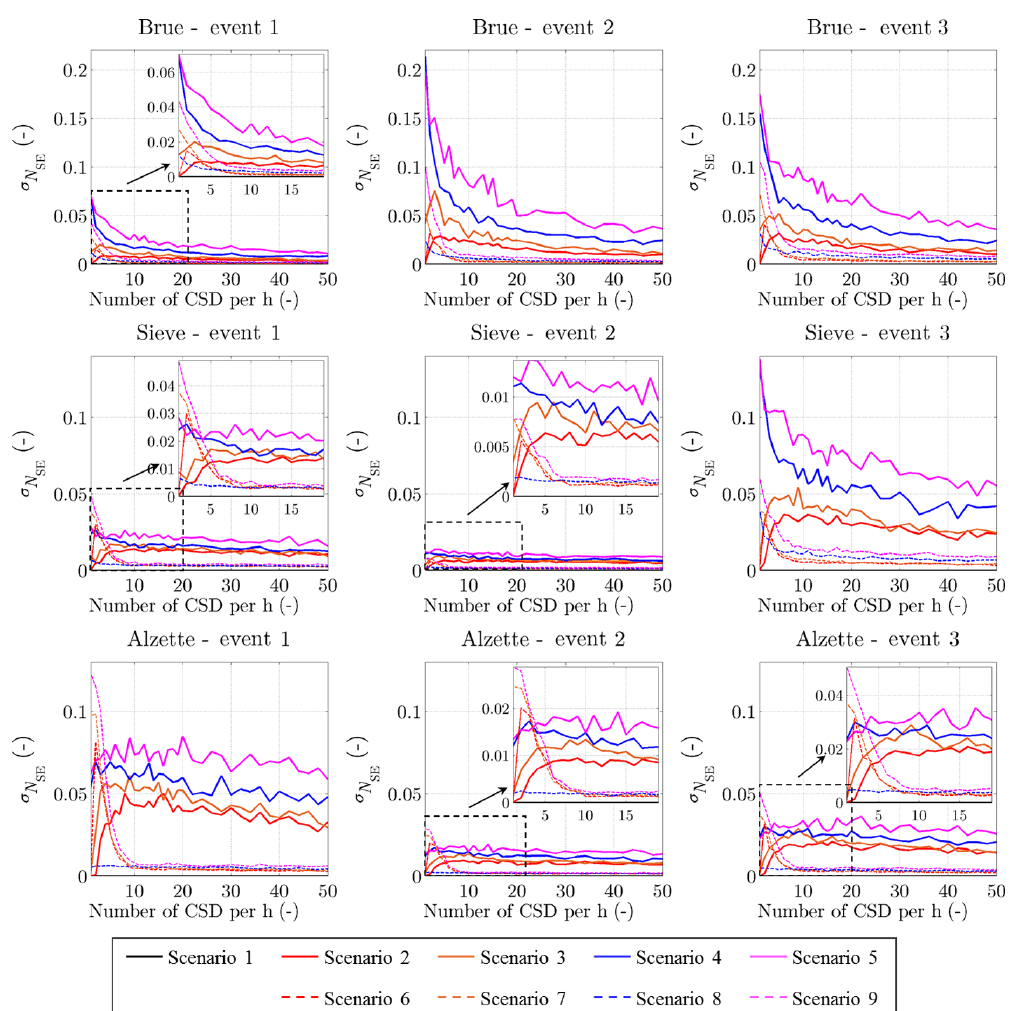
, on the number of streamflow crowdsourced SE